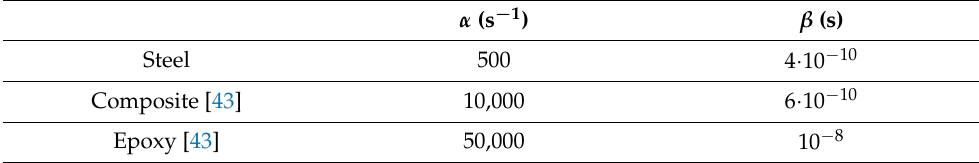
Table 2. Rayleigh parameters.